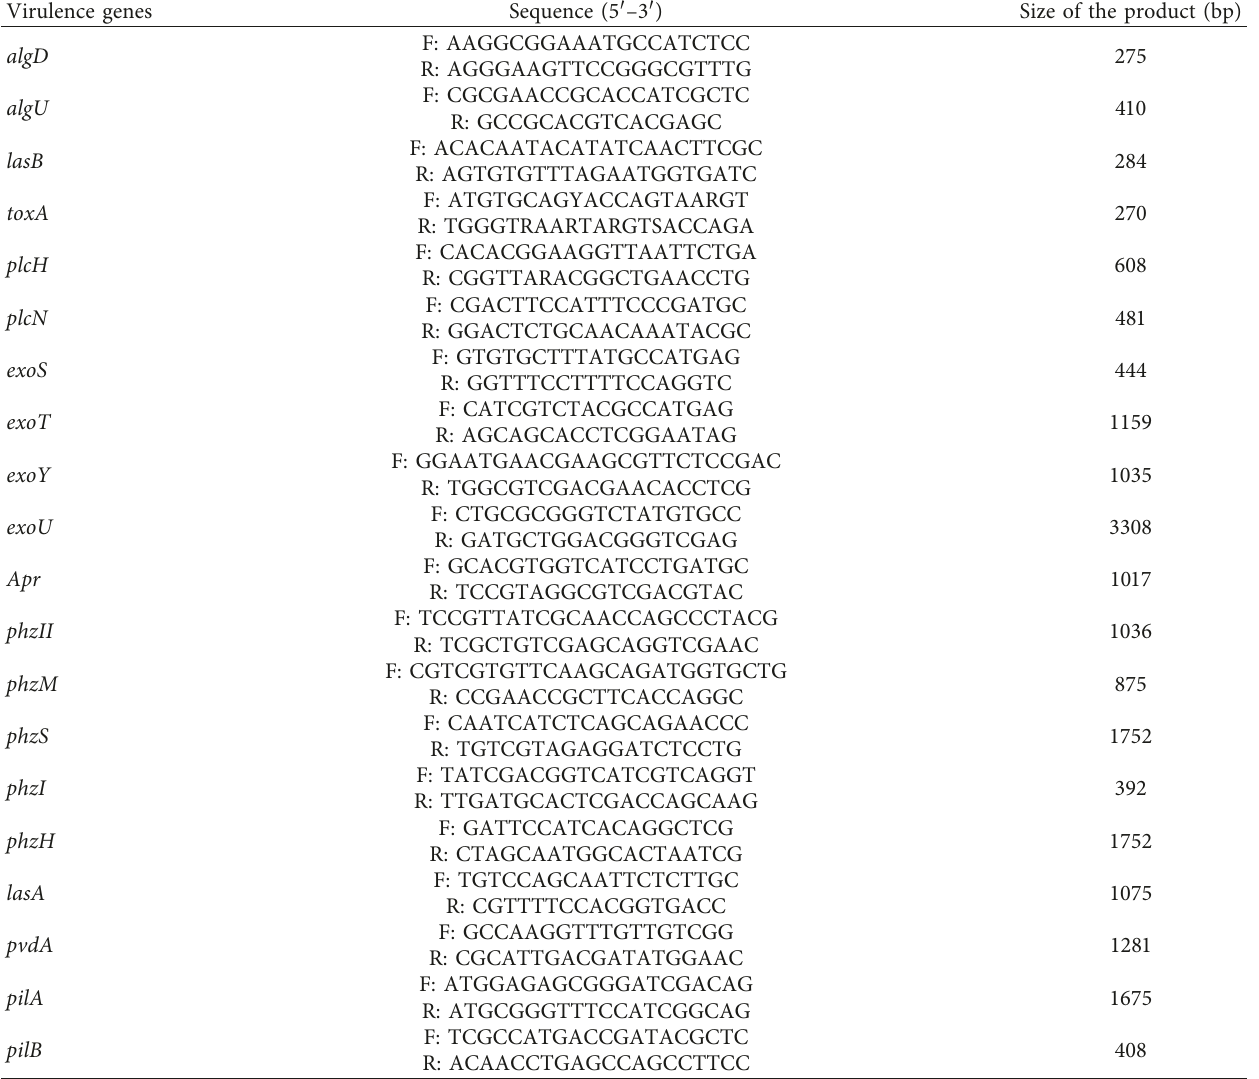
Table 1: List of primers used to detect virulence factors in Pseudomonas aeruginosa strains isolated from fish and seafood [8]. Virulence